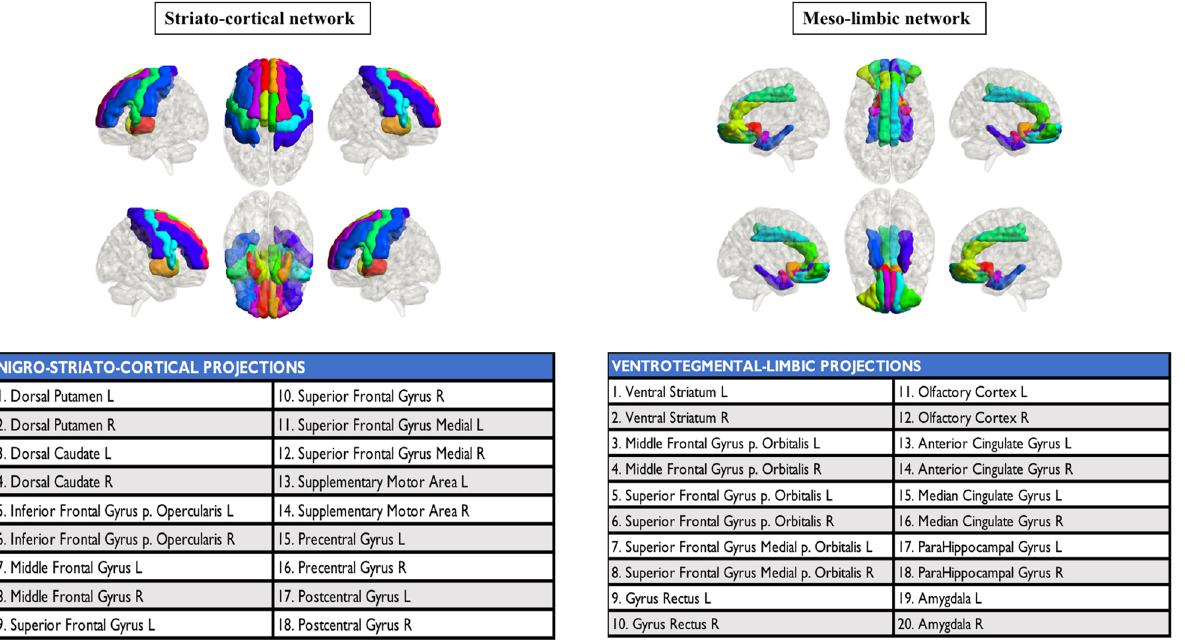
Figure 3. Dopaminergic networks. Cortical and subcortical projections of the two main dopaminergic pathways. R: right, L: